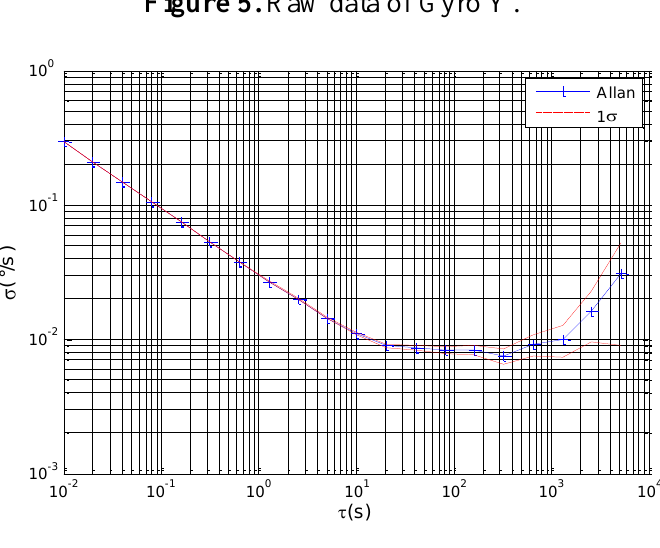
Figure 6. Allan variance plot of Gyro